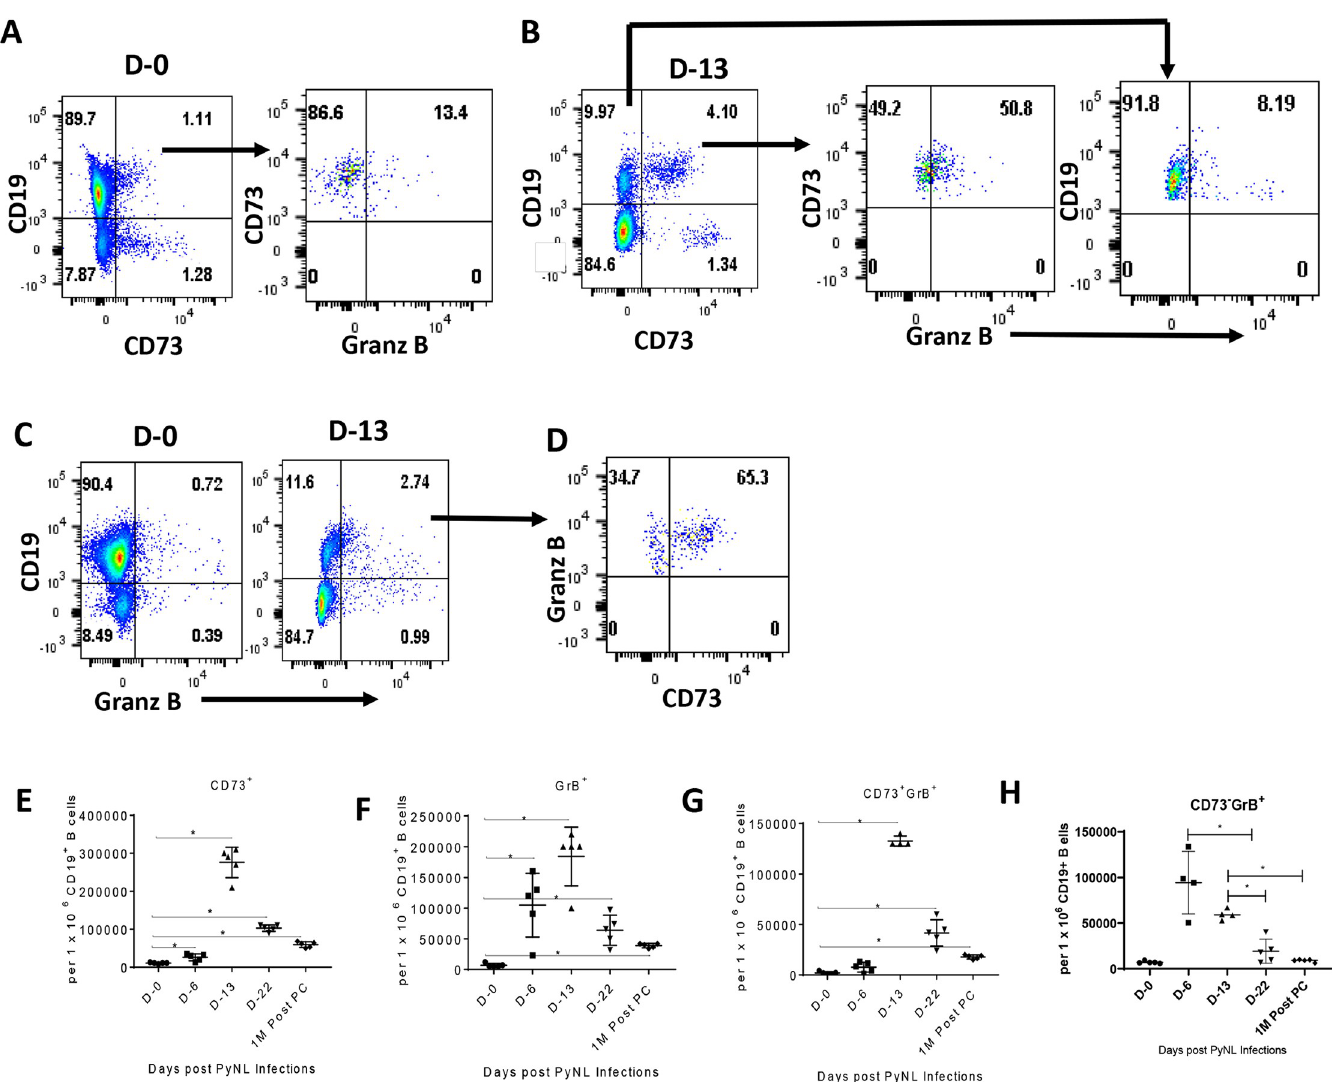
Fig 4. Comparison of CD19 + B cell frequencies expressing CD73 and/or Granzyme B at different time points following a primary PyNL infection and at one month post-parasitemia clearance. Representative flow cytometry dot plots show frequencies of CD19 - or CD19 + splenocytes (T cells were excluded) expressing CD73 or frequencies of CD19 + CD73 + B cells expressing Granzyme B (Granz B) at (A) Day 0 or (B) Day 13 post-PyNL infection. Alternatively, frequencies of CD19 - or CD19 + splenocytes expressing Granz B at (C) both time points or (D) frequencies of CD19 + Granz B + cells expressing CD73 at D-13 were determined. Also shown is the development of CD19 + B cells expressing (E) CD73, (F) Granzyme B (GrB), (G) both CD73 and GrB or (H) or CD73 - B cells expressing GrB following a primary PyNL infection beginning at Day 0 through Day 30 post-parasitemia clearance (PC). A representative experiment of two experiments is shown. Mann Whitney test was used for statistical evaluation. � p < 0.05; n = 5 mice per